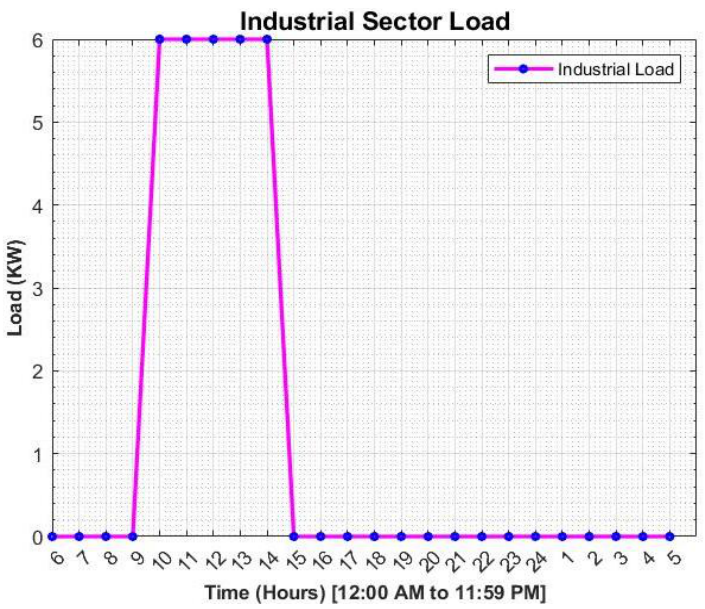
Figure 5. Industrial load for a single day.